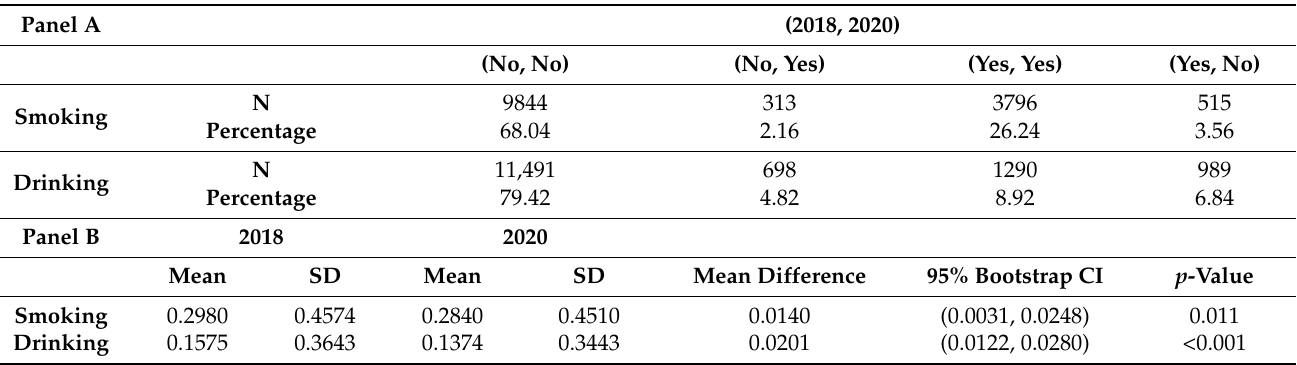
Table 2. Changes in smoking and drinking behaviors before and during the COVID-19 pandemic.